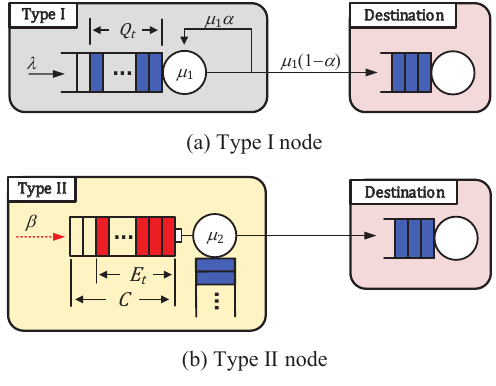
Figure 2. Modified system